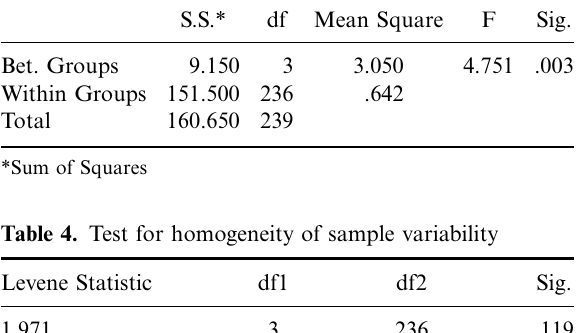
Table 3. ANOVA test for group means